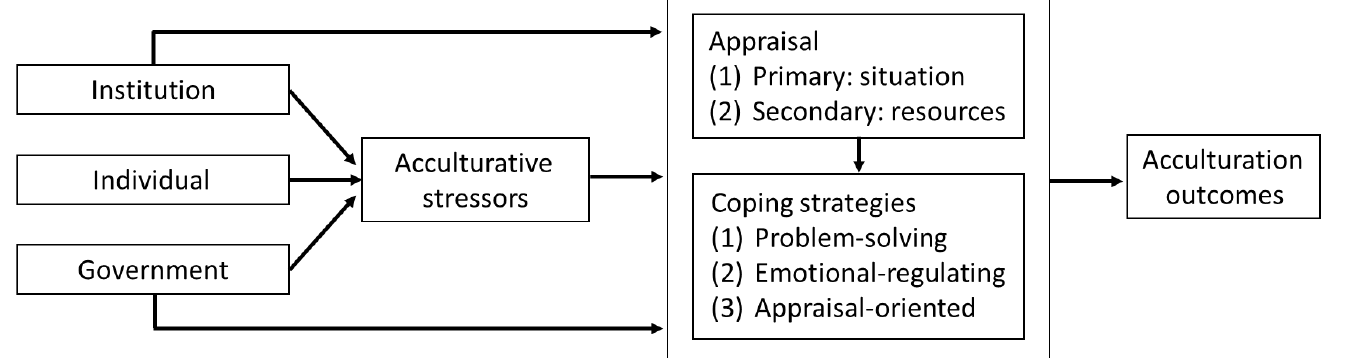
Figure 1. Conceptual framework of acculturation process (adapted from Lazarus, Berry, and Hajro et al.) [14,16,18]. Hajro et al.)